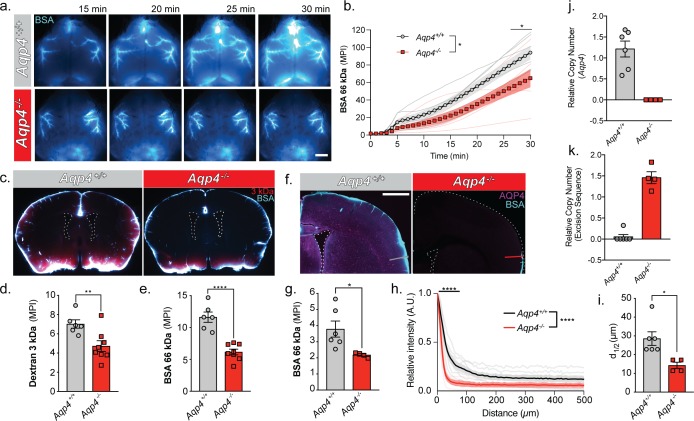
URMC: Glymphatic influx of CSF tracer is facilitated by AQP4.(a) Representative images from an in vivo transcranial optical imaging experiment of a WT control mice (Aqp4+/+) and Aqp4 KO (Aqp4-/-) mice starting at 15 min after intracisternal delivery of 10 µl (2 µl/min) of a 66 kDa fluorescent tracer, BSA-647. Scale bar: 2 mm. (b) Mean pixel intensity (MPI) of BSA-647 over a 30 min experiment, imaging was started at the beginning of the injection. Two-way repeated measures ANOVA with Sidak’s multiple comparisons test, overall model *p = 0.0329, multiple comparisons *p < 0.05; n = 6–7/group. (c) Coronal sections collected 30 min after intracisternal injection of two varying molecular size tracers, 3 kDa Texas Red dextran and BSA-647. Mean pixel intensity for a (d) 3 kDa dextran and (e) BSA from six coronal sections between +1.2 and −1.8 mm from bregma for each animal. Two-tailed unpaired t-test, **p = 0.0097, ****p < 0.0001; n = 6–8/group. (f) Coronal section from an Aqp4+/+ mouse stained and imaged for AQP4 (magenta) and BSA-647 tracer (cyan). (g) Mean pixel intensity from a replicate experiment quantified the same as (e). Two-tailed unpaired t-test, *p = 0.0335, n = 4–6/group. (h) Mean tracer penetration depth profiles normalized to the fluorescence at the pial surface of a coronal section at bregma from the set of experiments displayed in (g). The line was placed orthogonal to the cortical surface at the most dorsal position where tracer could be found at the pial surface (f). Tracer depth in the WT mice was measured at the same position as the KO mouse. Two-way repeated measures ANOVA with Sidak’s multiple comparisons test, overall model ****p < 0.0001, multiple comparisons ****p < 0.0001, n = 4–6/group. (i) Cortical depth at which the fluorescence at the surface decreases by half for the profiles in (h). Two-tailed unpaired t-test, *p = 0.0161, n = 4–6/group. (j) Relative copy numbers (RCN) of the Aqp4 gene locus and the excision sequence (k) showing successful deletion of Aqp4 exon 1–3. RCN was quantified by qPCR for mice used in the experiment in (g). Data expressed as mean ±SEM (Figure 5—source data 1).10.7554/eLife.40070.010Figure 5—source data 1.Source data for Figure 5.